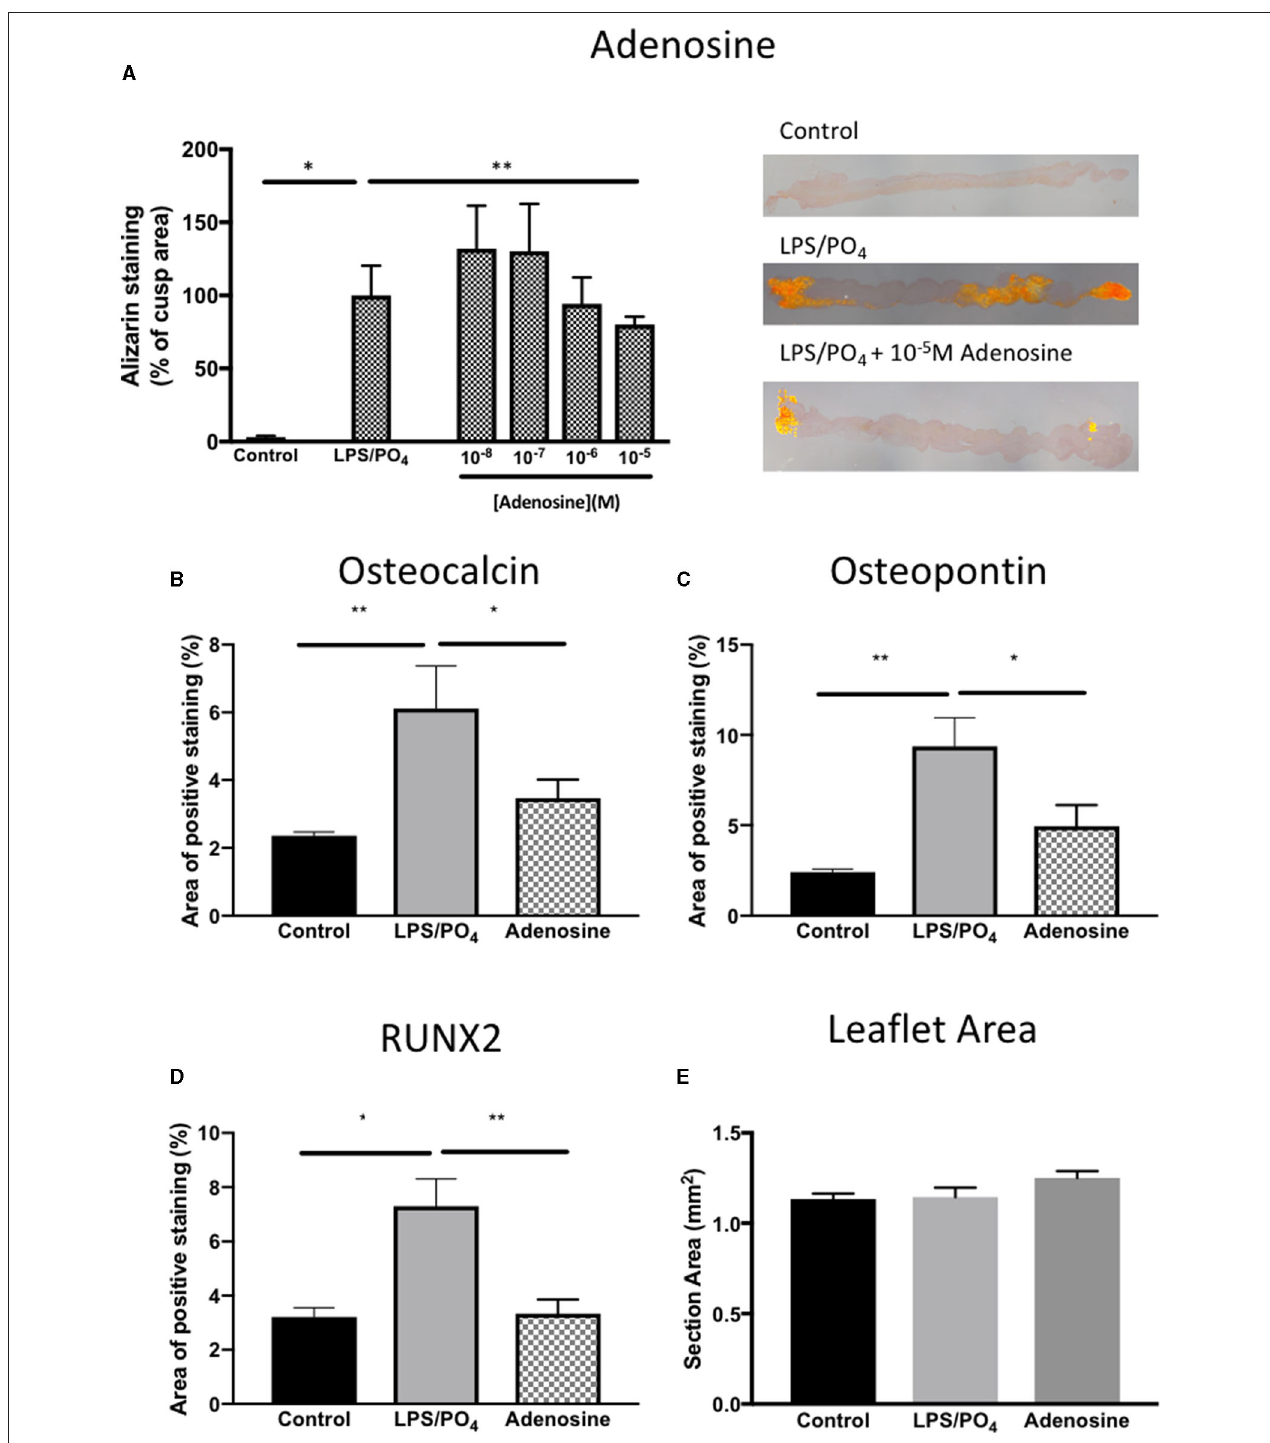
FIGURE 10 | Inhibitory effect of adenosine on calcification and expression of osteogenic markers. Effect of increasing concentrations of adenosine (10 − 8 -10 − 5 M) on the expression of Alizarin Red in sections of valve leaflet response to 100ng/mL and 3mM phosphate (* P = 0.008, T -Test; n = 8 and ** P = 0.011, T -Test; n = 6) and representative images of sections stained with Alizarin Red imaged under polarized light for each treatment group (A) . Quantification of the area of positive staining in control (media alone), 100ng/mL and 3mM phosphate and 100ng/mL & 3mM phosphate with 10 − 5 M adenosine for (B) osteocalcin (** P = 0.001, * P = 0.029, ANOVA; n = 11–15 areas from 3 valves), (C) osteopontin (** P < 0.001, * P = 0.029, ANOVA; n = 13–15 areas from 3 valves) and (D) RUNX2 (* P = 0.003, ** P = 0.001, ANOVA; n = 9–14 areas from 3 valves). (E) The mean area per measurement was similar in all 3 groups.